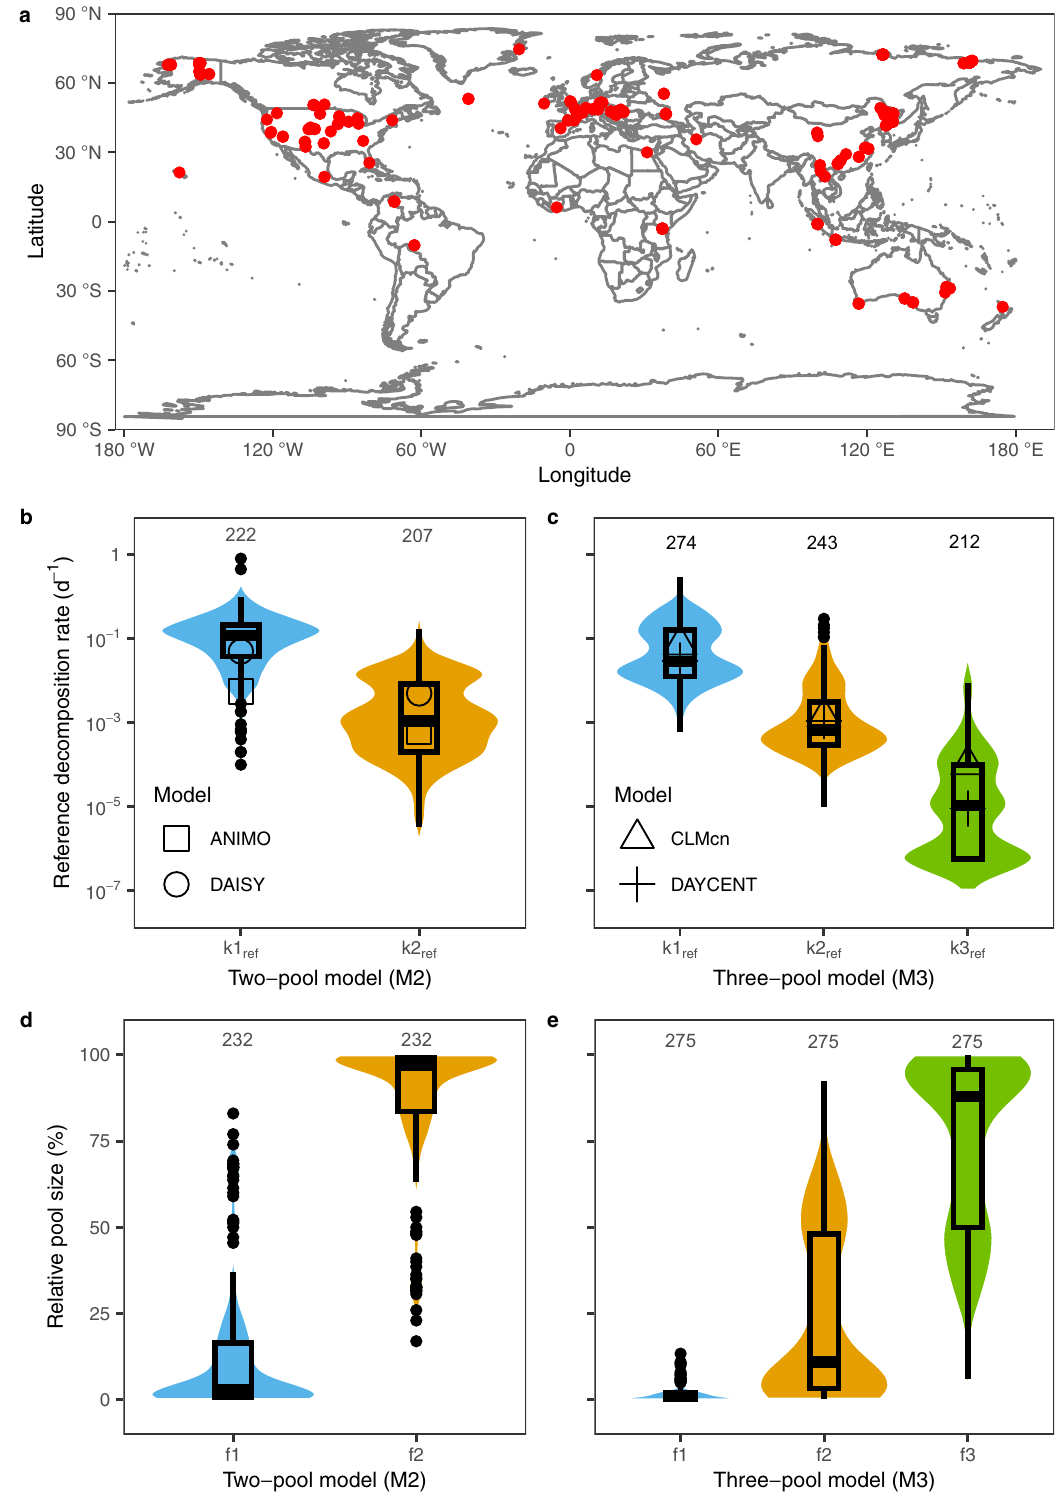
Fig. 1 | Geographic locations of soil sampling sites and comparison of soil organicmatter(SOM)decompositionkineticsparameters.a Globaldistribution of sampling sites. b , c Referencedecomposition rates (k1 ref , k2 ref , and k3 ref ) for the fast, slow, and passive SOM pool in the two-pool model (M2) and the three-pool model (M3), respectively. d , e Relative sizes (f1, f2, and f3) for the fast, slow, and passive SOM pool in the two- and three-pool model, respectively. In b – e the band